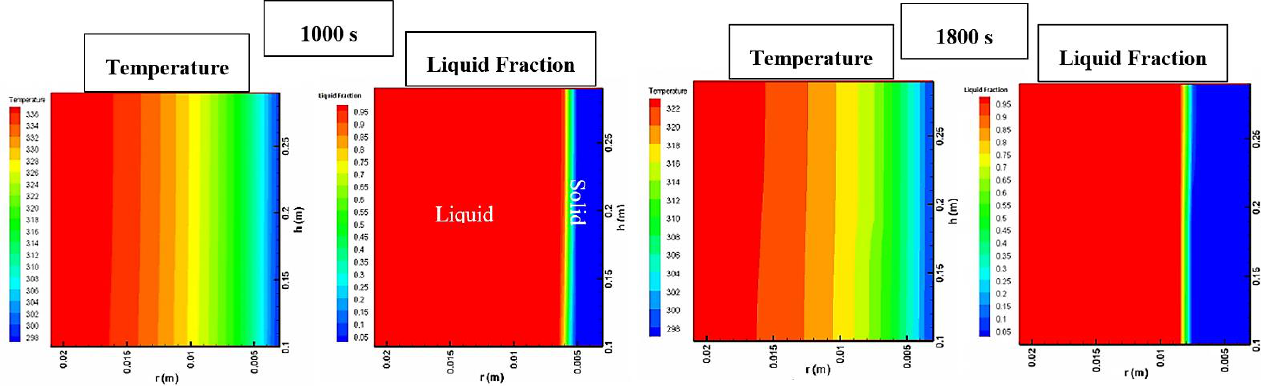
Figure 12. Numerical temperature and liquid fraction contour for charging process (T = 70 °C).